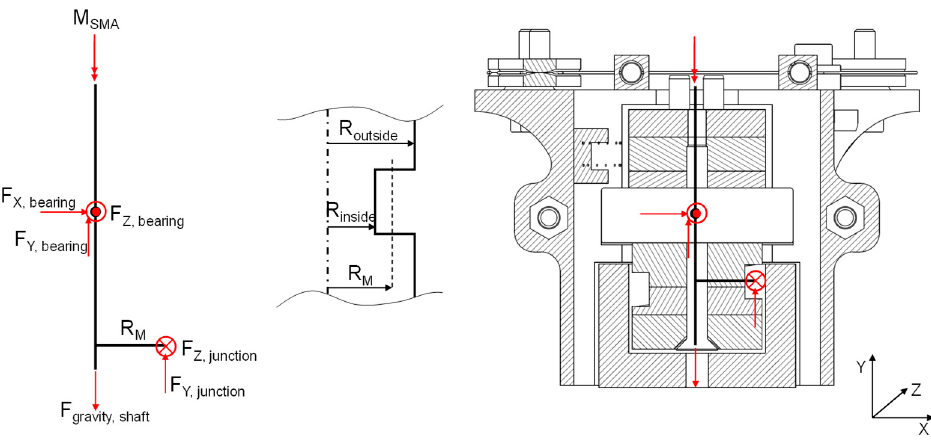
Figure 10. Transmission via the shaft and determination of the for calculations required radius (mean value of inner and outer radius).